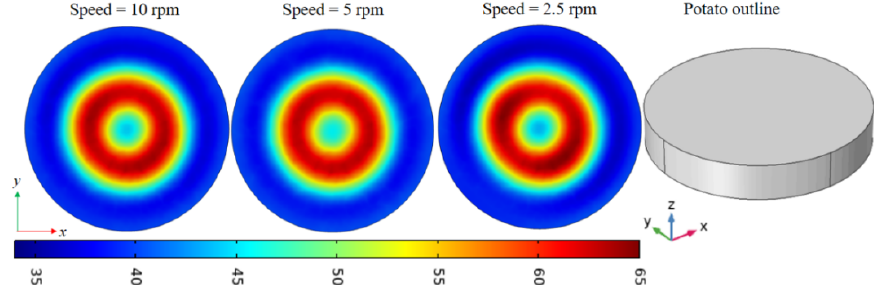
Figure 13. The average temperatures of the cubic potato heated with different rotational speeds.